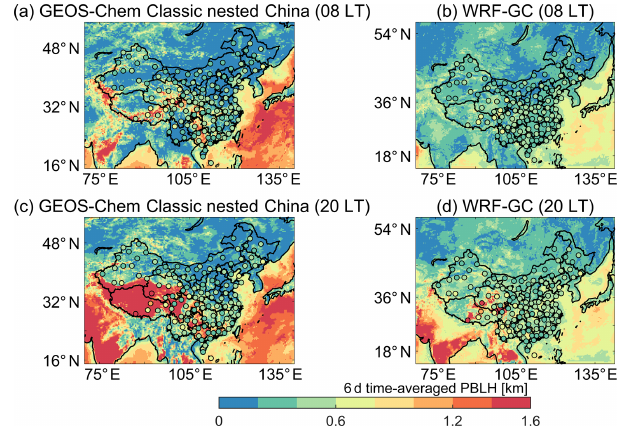
Figure 5. Comparison of the simulated (fill contours) and ob- served (fill symbols) planetary boundary layer heights (PBLHs) at 08:00LT (a, b) and 20:00LT (c, d) averaged between 22 and 27 Jan- uary 2015. (a, c) PBLH from the GEOS-FP dataset, which was used to drive the GEOS-Chem Classic nested-China simulation, and (b, d) PBLH simulated by the WRF-GC